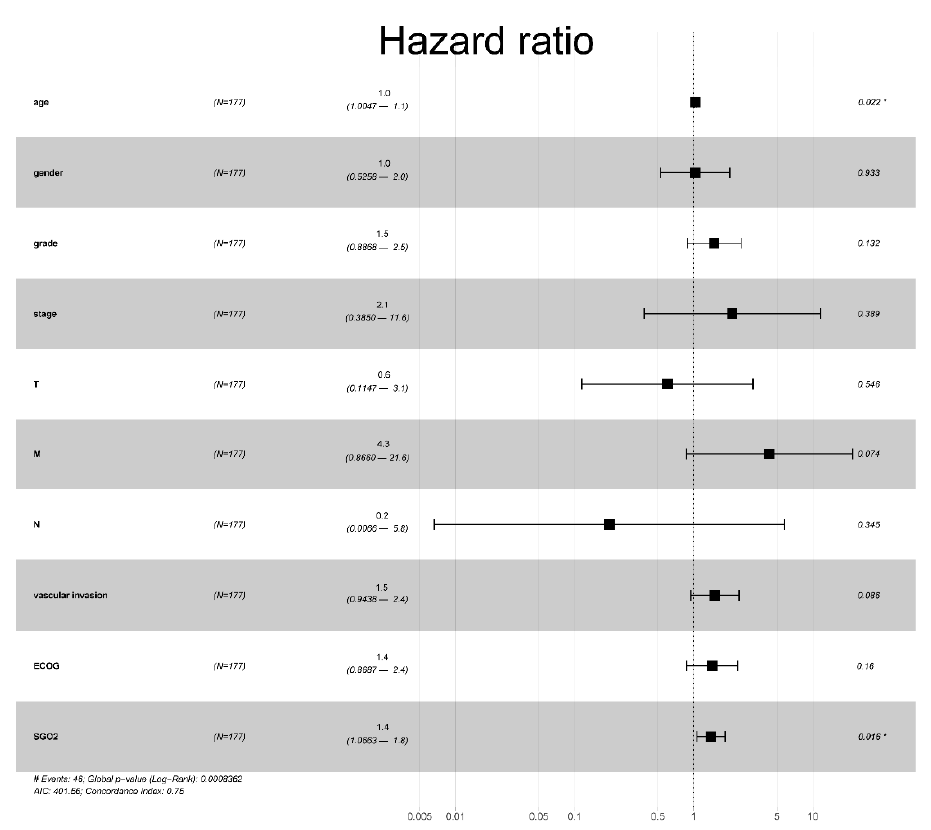
Figure 3. Forest plot for the multivariate Cox proportional hazard regression model. Age (HR, 1.0;